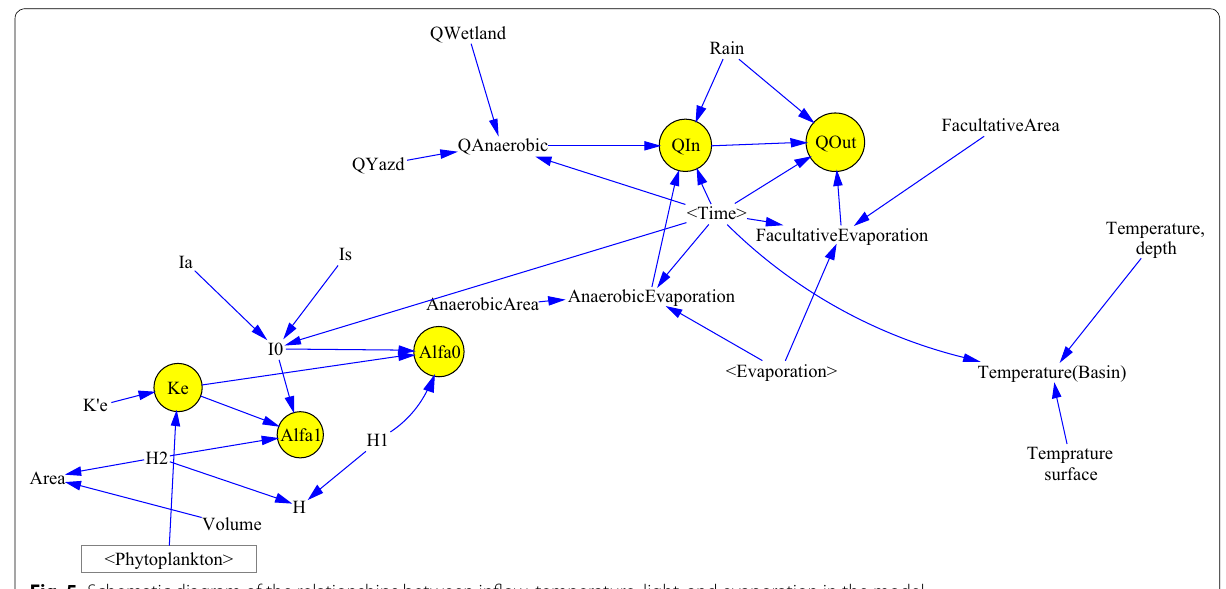
Fig. 5 Schematic diagram of the relationships between inflow, temperature, light, and evaporation in the model